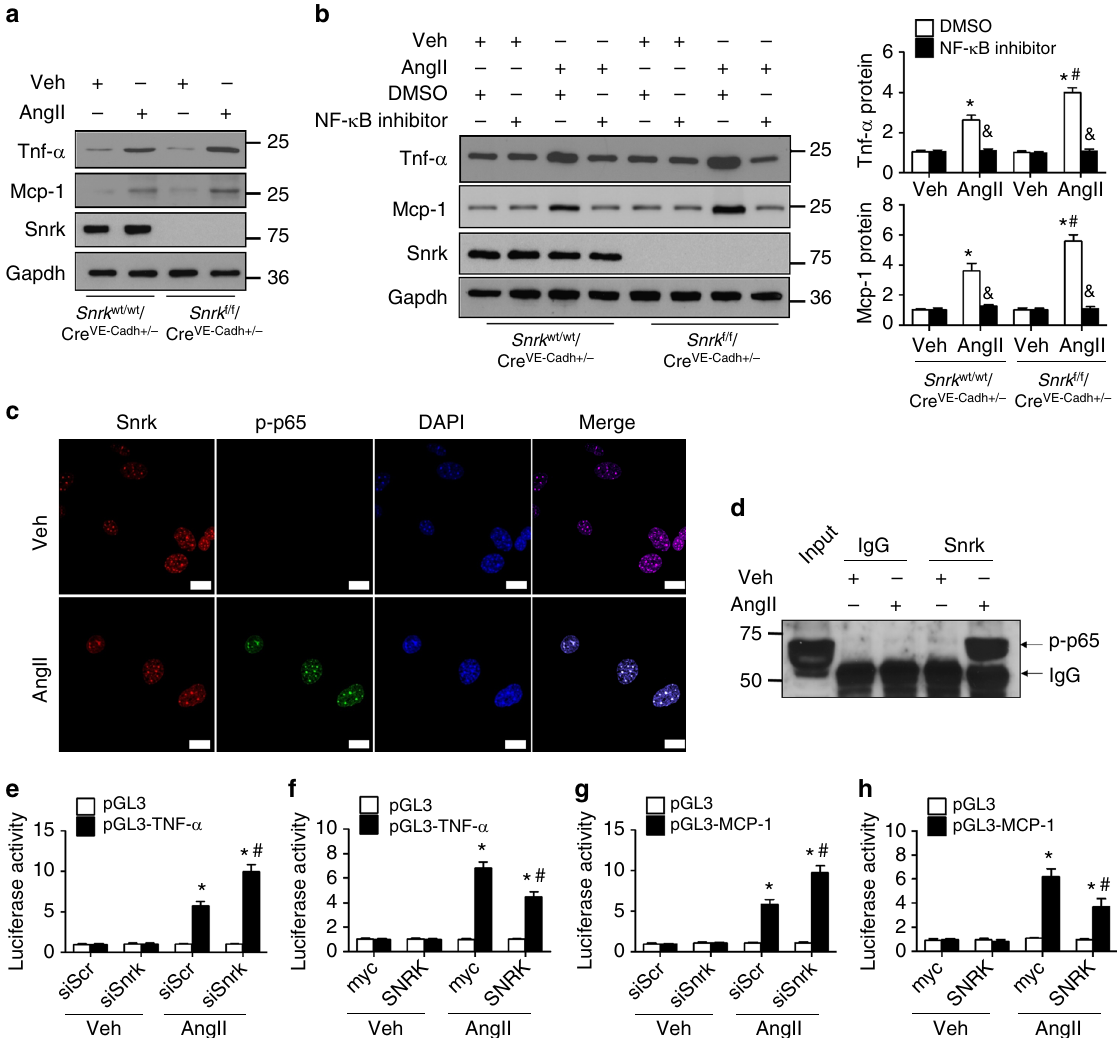
Fig. 8 Lack of endothelial Snrk enhances AngII-induced in fl ammation by potentiating the NF- κ B pathway. Primary GnECs were isolated from Snrk wt/wt / Cre VE-Cadh + / − (WT) and Snrk f/f /Cre VE-Cadh + / − mice. a Cell lysates of GnECs treated with AngII (1 µ M) or a vehicle control (Veh) for 24 h were subjected to western blot analysis of Mcp-1, Tnf- α , Snrk, and Gapdh levels. b GnECs were pretreated with DMSO or an NF- κ B inhibitor for 2 h, followed by incubation with AngII or a vehicle control for 24 h. Levels of indicated proteins were determined using western blot and densitometry analysis. n = 6, * p < 0.05 relative to vehicle control; # p < 0.05 relative to GnECs from WT mice; & p < 0.05 relative to DMSO control/AngII. c WT GnECs were treated with AngII for 24 h. The subcellular distribution of Snrk (red) and phosphorylated p-65 (p-p65; green) was determined by double staining (scale bar = 10 µ m). d The interaction between SNRK and p-p65 in GnECs in the absence or presence of AngII was assessed using immunoprecipitation and western blot analysis. Input, total cell lysates; IgG, immunoprecipitated with IgG. e – h The effects of Snrk knockdown ( e , g ) or overexpression ( f , h ) on luciferase reporter activity from the Tnf- α ( e , f ) or the Mcp-1 ( g , h ) promoter. siScr, knockdown control; siSNRK, Snrk knockdown; myc, Myc overexpression vector control; SNRK, Snrk overexpression; pGL3, empty luciferase reporter vector; pGL3-TNF- α , Tnf luciferase reporter; pGL3-MCP-1, Mcp-1 luciferase reporter. e – h , n = 5. ( e , g ) * p < 0.05 relative to pGL3; # p < 0.05 relative to si Scr . ( f , h ) * p < 0.05 relative to pGL3; # p < 0.05 relative to myc. Student ’ s two-tailed t -test was used for the statistical analysis. The corresponding source data are available in the Source Data fi (Fig. 8b and Supplementary Fig. 14). Next, we analyzed the sub- cellular localization of Snrk and phosphorylated p65 in GnECs using immuno fl uorescence. AngII increased p65 phosphorylation and nuclear translocation (Fig. 8c). Phosphorylated p65 (p-p65) staining overlapped with Snrk staining in the nuclei of AngII-treated GnECs (Fig. 8c). Also, immunoprecipitation of Snrk followed by probing for p-p65, and vice versa, indicating that Snrk is physically associated with p-p65 (Fig. 8d and Supplementary Fig. 15), suggesting that Snrk modulates the AngII-activated NF- κ B/p65 pathway that con-